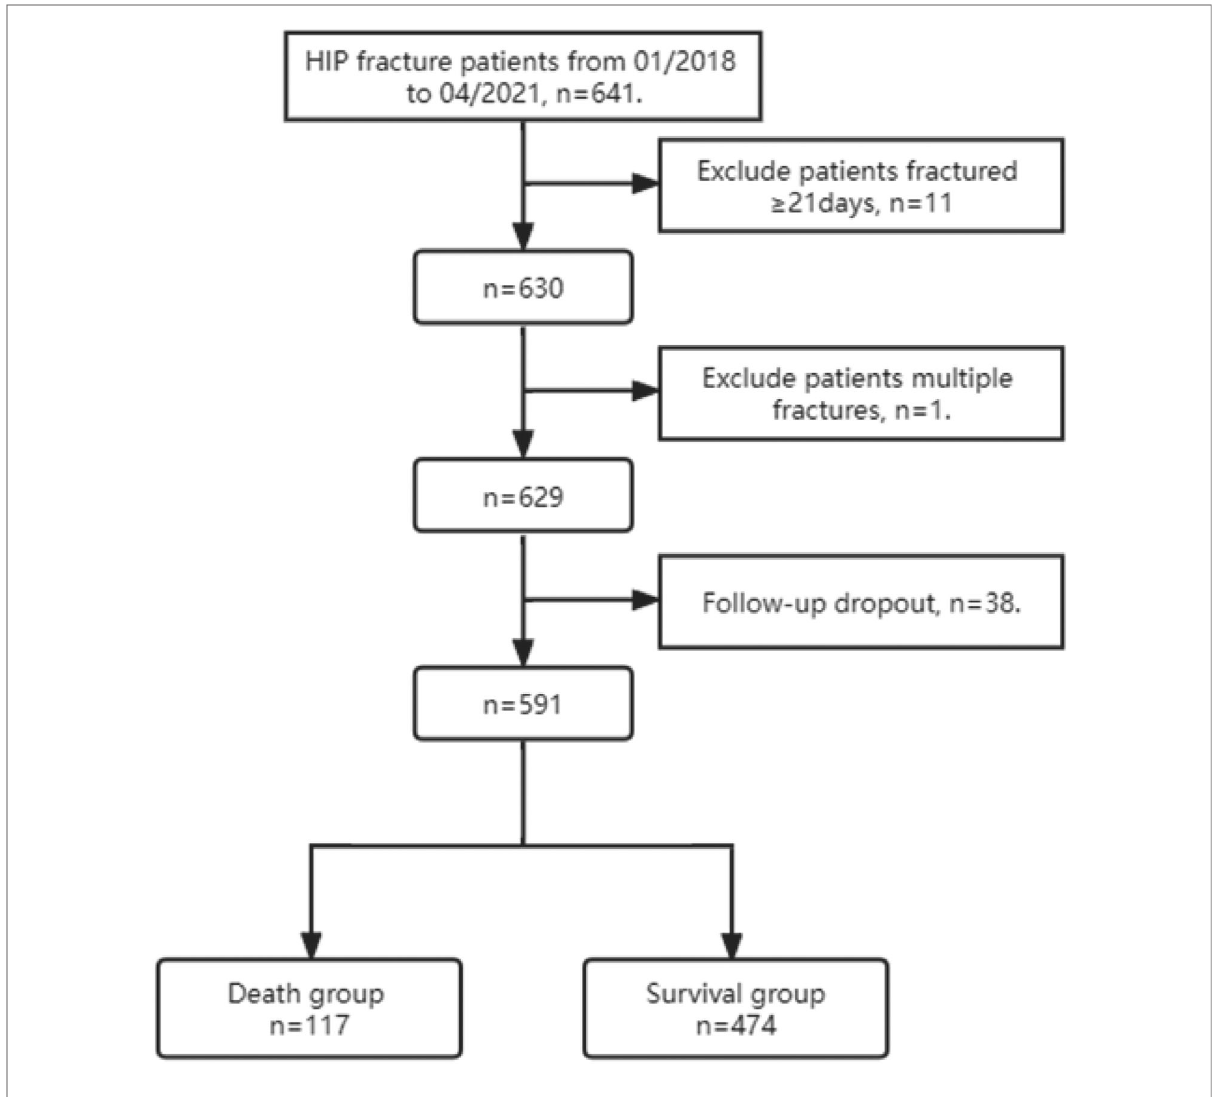
FIGURE 1 CONSORT